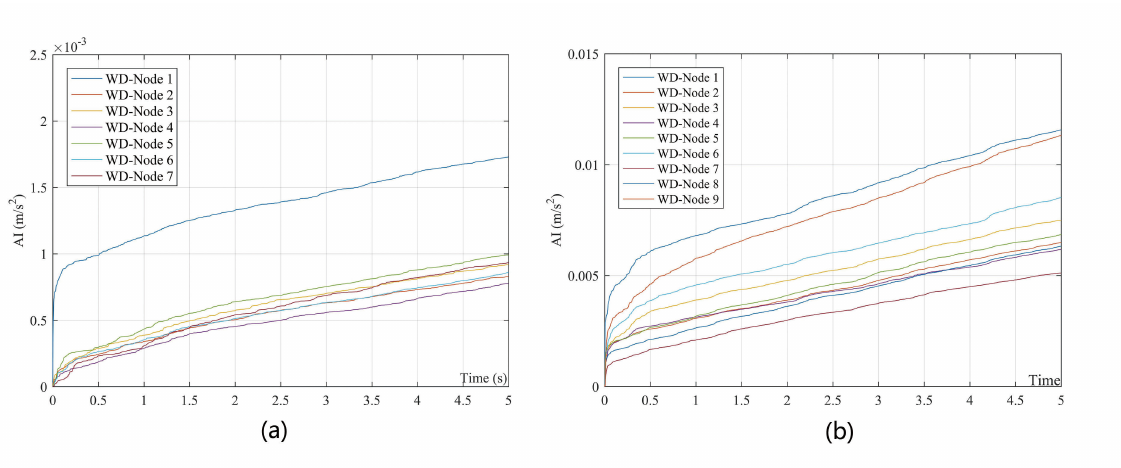
Figure 12. The AIs calculated from the RDSs for each sensor of the intact structure individually, considering the speed as v = 0.3 m/s. ( a ) Al calculated for intact bridge and ( b ) AI calculated for the intact beam.